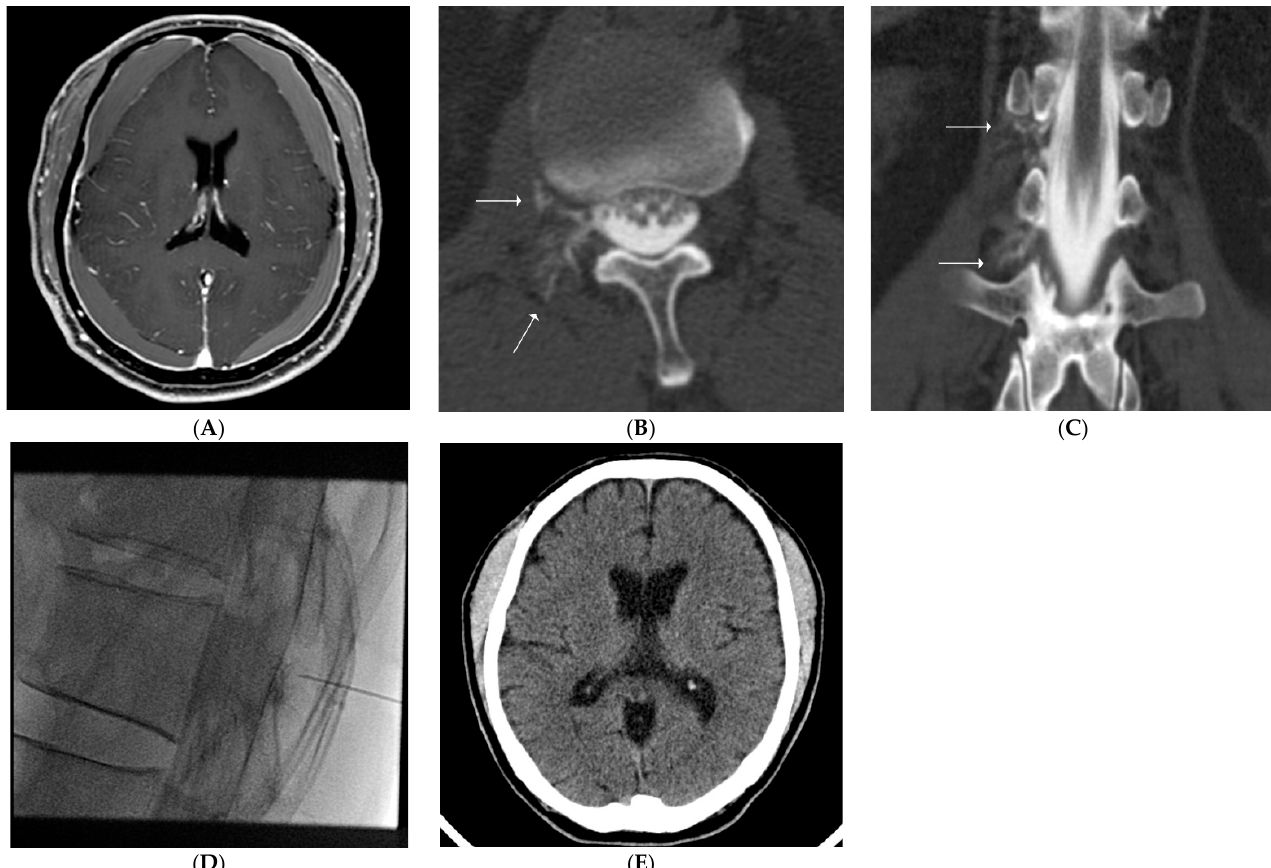
Figure 2. ( A – E ). Findings for a representative case involving a 70-year-old man with nontraumatic intracranial subdural hematoma (SDH). The patient presented with a chief complaint of headache not related to a specific posture. ( A ). Contrast-enhanced, fat-suppressed T1 weighted image shows bilateral nontraumatic SDH with pachymeningeal thickening and enhancement. ( B , C ). Axial and coronal computed tomography (CT) myelography images show cerebrospinal fluid leaks at the level of the T12/L1 and the L1/2 right extradural space (solid arrows). ( D ). An epidural blood patch is performed at the T12/L1 level. Intrathecal staining is present due to a previously injected contrast agent for CT myelography. ( E ). Follow-up brain CT performed after 3 months shows no evidence of SDH.